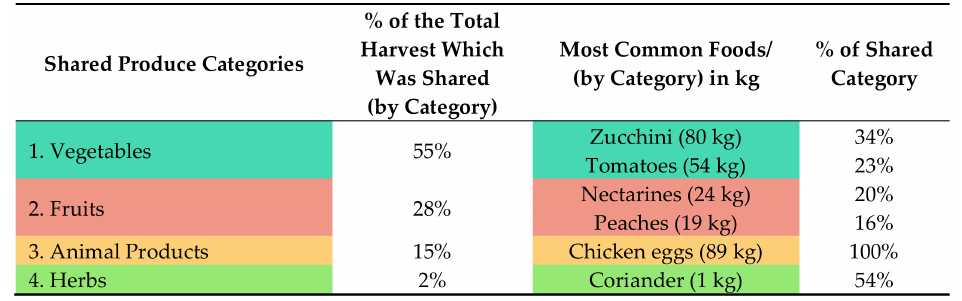
Table 6. Tracked food sharing by produce category by EG participants (n = 39) during Phase 2 of the EG